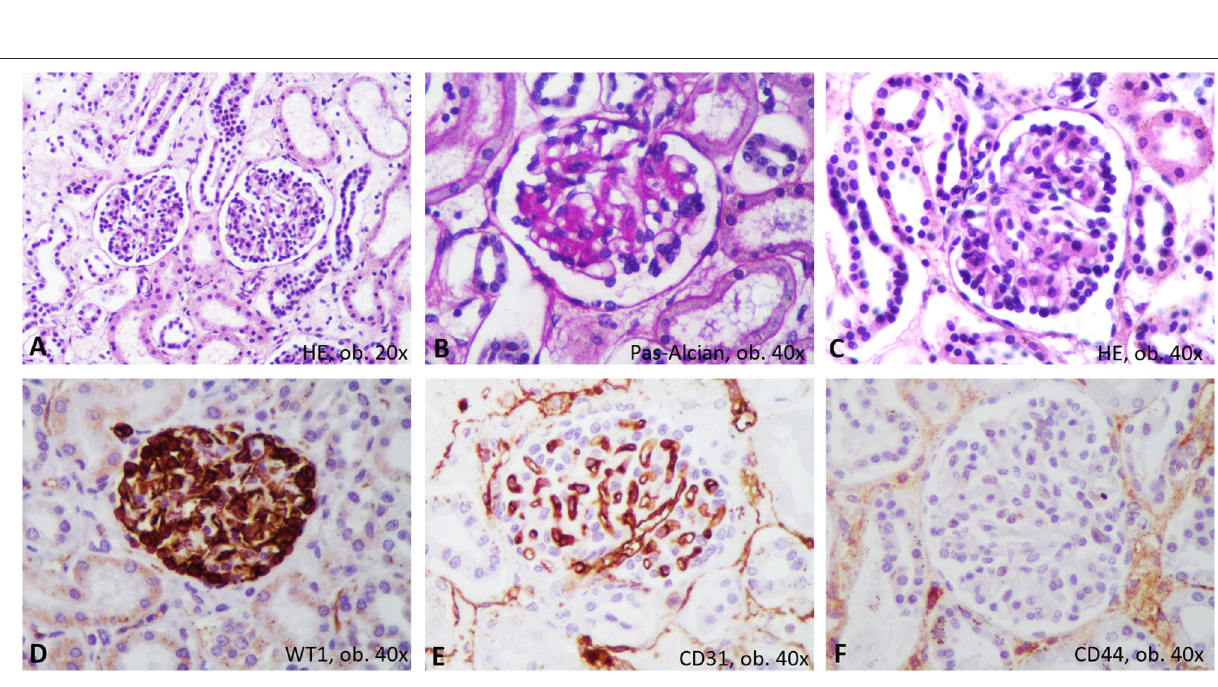
Frontiers in Pediatrics |